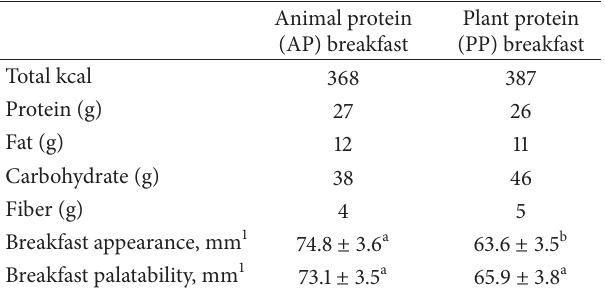
Table 2: Dietary characteristics of test breakfasts. Animal protein Plant (AP) breakfast